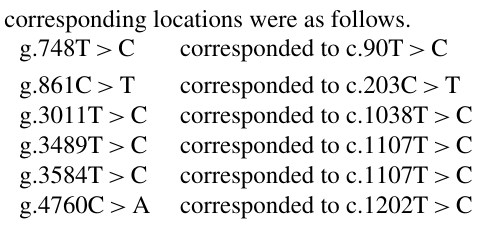
corresponding locations were as